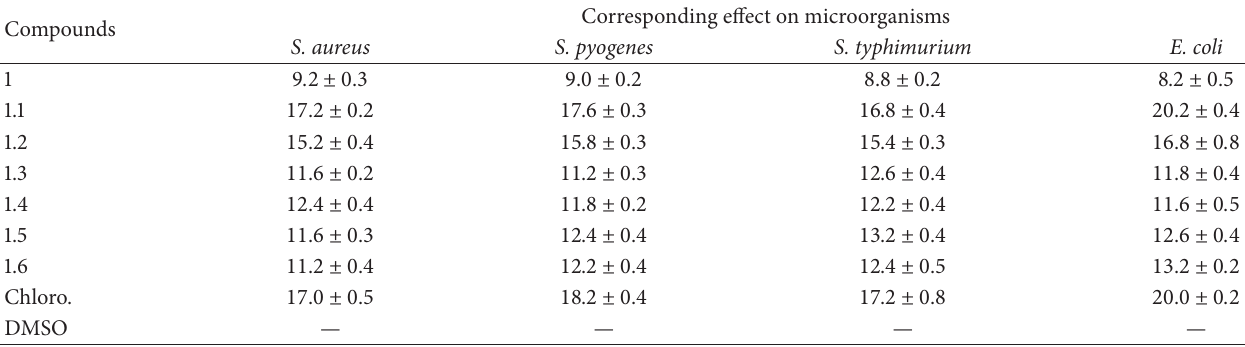
Table 1: Antibacterial activity of thiosemicarbazone and its metal complexes, positive control chloramphenicol (Chlora.) and negative control (DMSO) measured by the halo zone test (unit, mm). Compounds